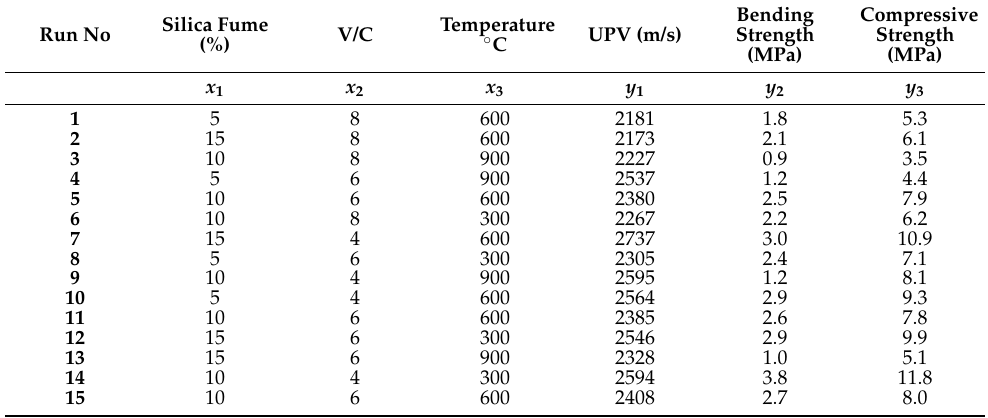
Table 4. Design matrix and responses